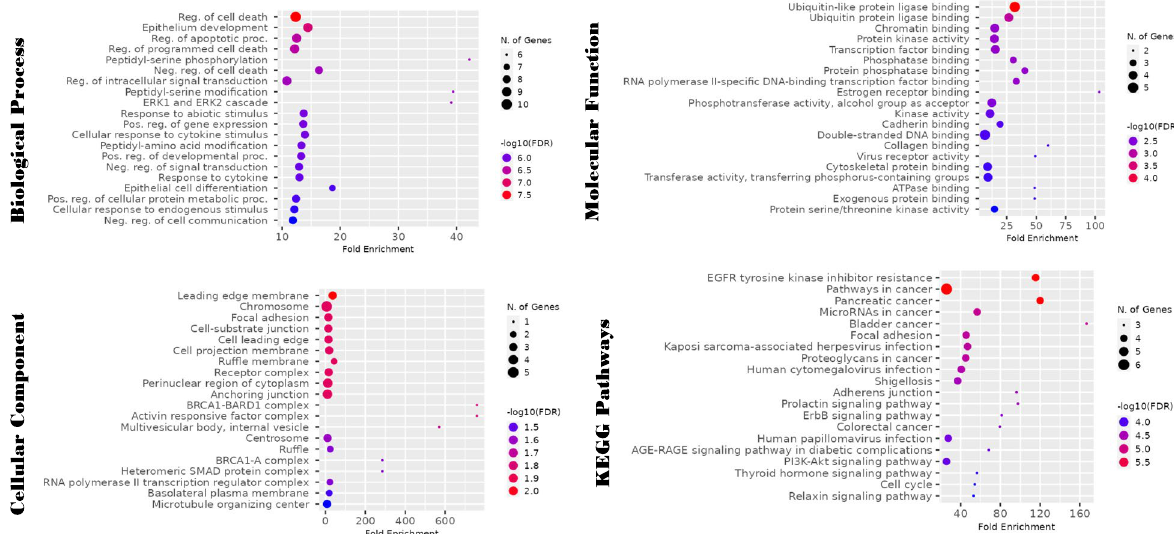
Fig. 3 The significant top twenty GO terms and KEGG pathways in which the hub genes are